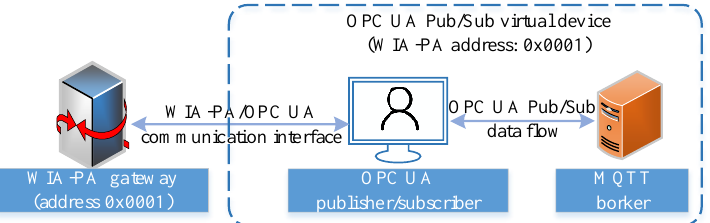
Figure 7. OPC UA pub/sub virtual device.